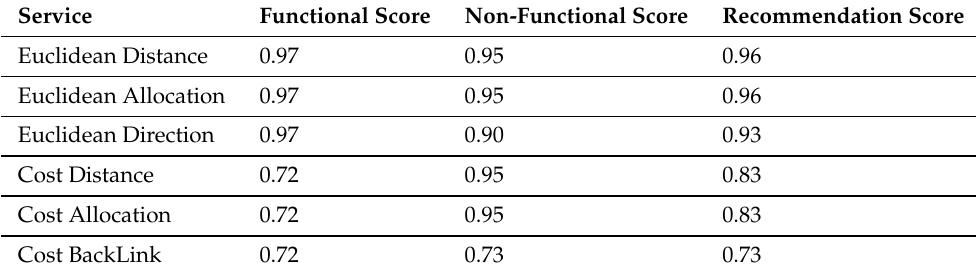
Table 7. Recommendation score associated to the request R1 .